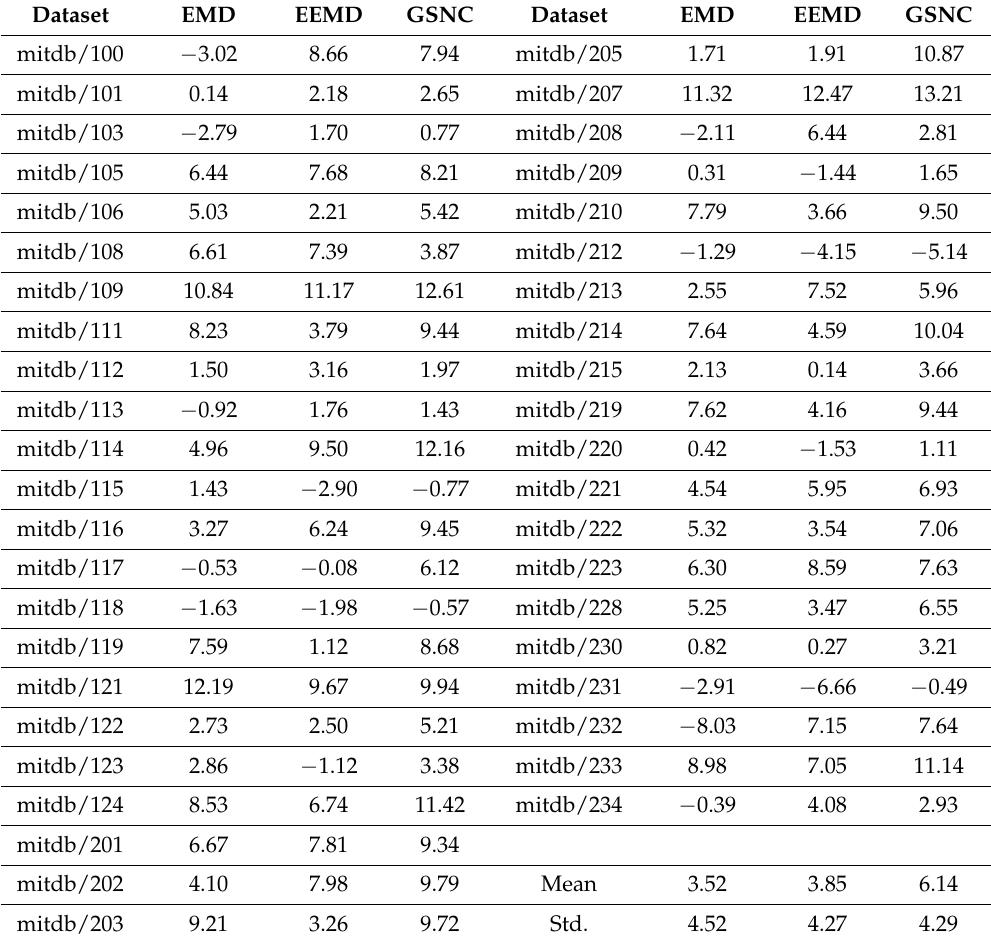
Table 4. The NER dB for the proposed GSNC and the compared schemes with the EMG noise ( SNR = 5 dB )